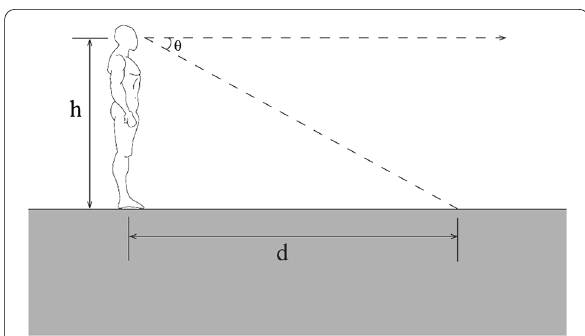
Fig. 5 For a viewer standing on a ground plane, the distance ( d ) to locations on the ground can be computed using the horizon‑distance relation (angle of declination), scaled by eye height